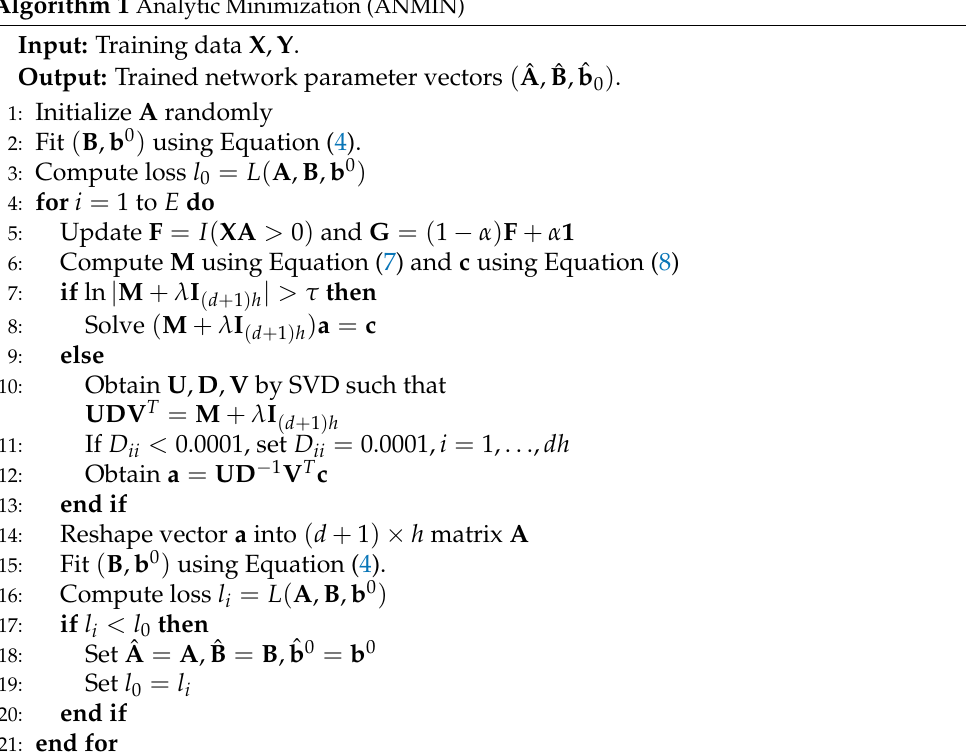
Algorithm 1 Analytic Minimization